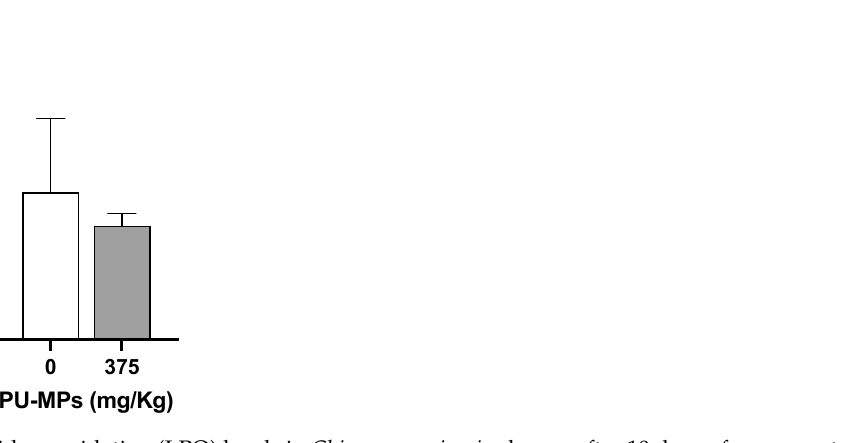
Figure 5. Effect of polyurethane microplastics (PU-MPs) on ( A ) aerobic energy production (electron transport system, ETS, mJ/h/mg organism), ( B ) proteins, ( C ) lipids, and ( D ) carbohydrates content (mJ/mg organism) of Chironomus riparius larvae after 10 days of exposure (n = 5). All values are presented as mean ± standard error of the mean. *** denotes a significant difference from the control ( p < 0.001).